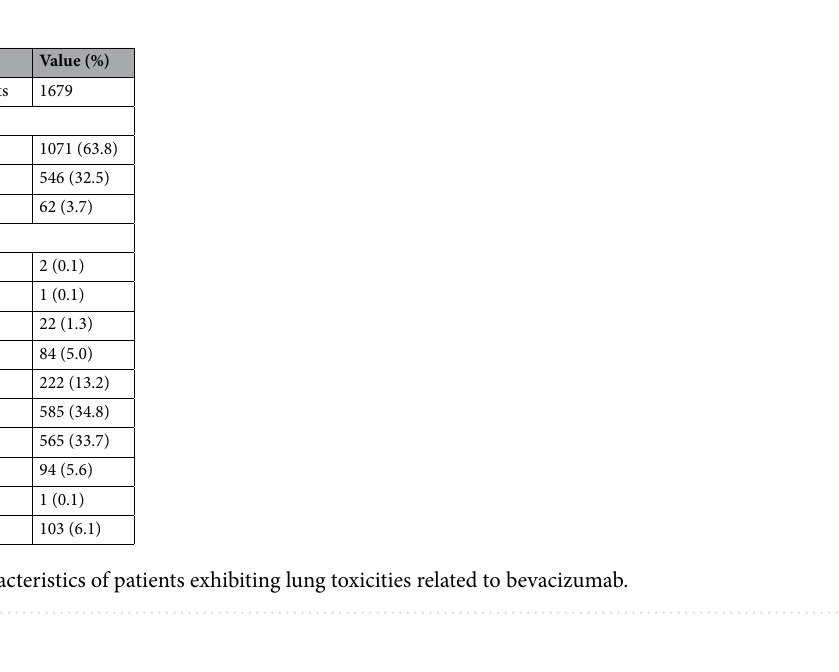
Figure 1. Process of constructing a data analysis table.